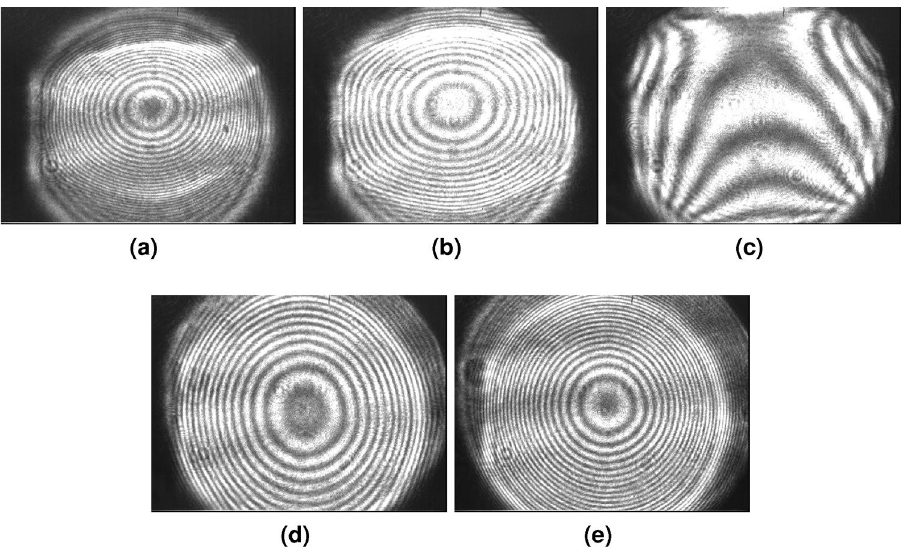
Figure 5. CCD Interferograms for sample ’E’ (Thorlabs beam splitter cube) with TFL focal length tuned from higher to lower values and passing through the balanced interferometer configuration (in Fig.5c). Focal length values correspond to ( a ) f = 222mm , ( b ) f = 227mm , ( c ) balanced interferometer interferogram at f = 237mm , ( d ) f = 247mm , and ( e ) f =